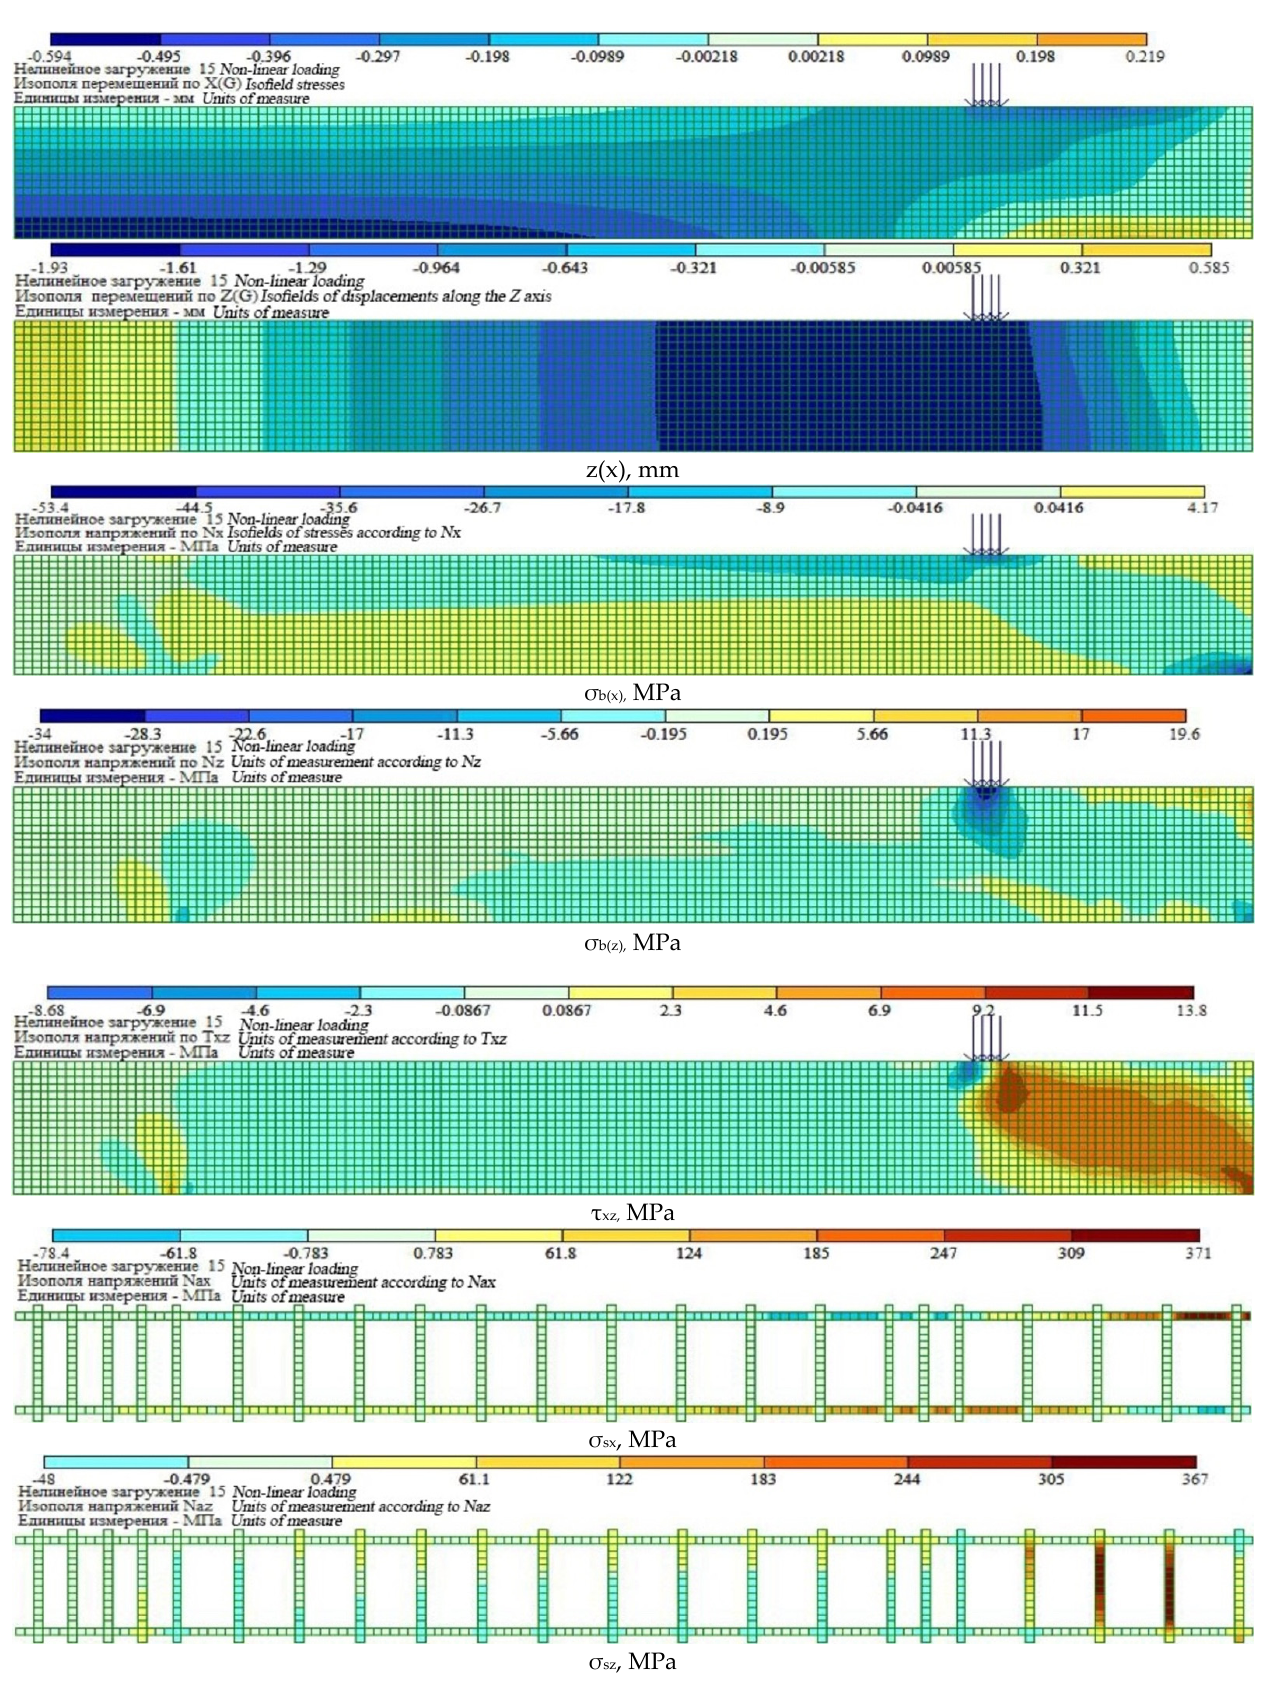
Figure 6. Isofield of displacements and stresses of a continuous beam destroyed according to the punching scheme on the middle support ( F/V scheme), experiment No. 27.